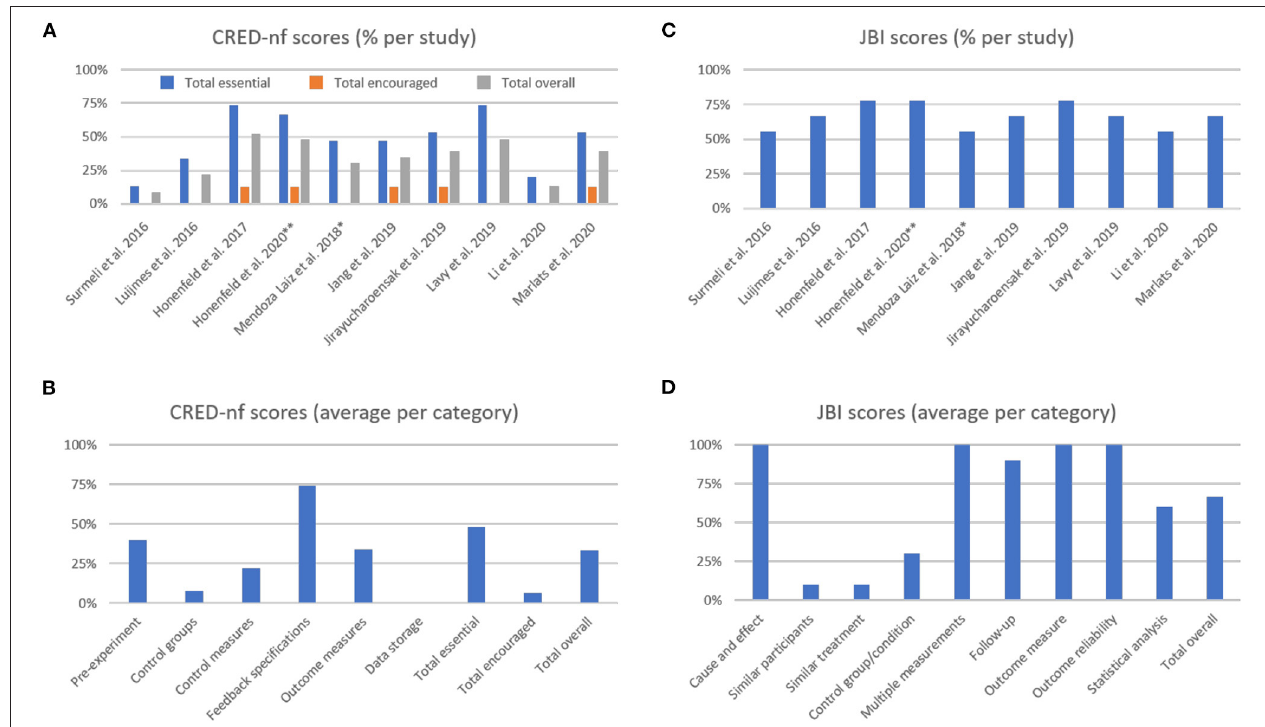
FIGURE 3 | The Consensus on the Reporting and Experimental Design of Neurofeedback studies (CRED-nf) percentage scores (A) per study, and (B) averaged per category. The Joanna Briggs Institute (JBI) averaged percentage scores (C) per study, and (D) averaged per category. **Methodological information detailed in previous publication from Hohenfeld et al. (2017); *Methodological information detailed in previous publication from Gomez-Pilar et al. (2016).